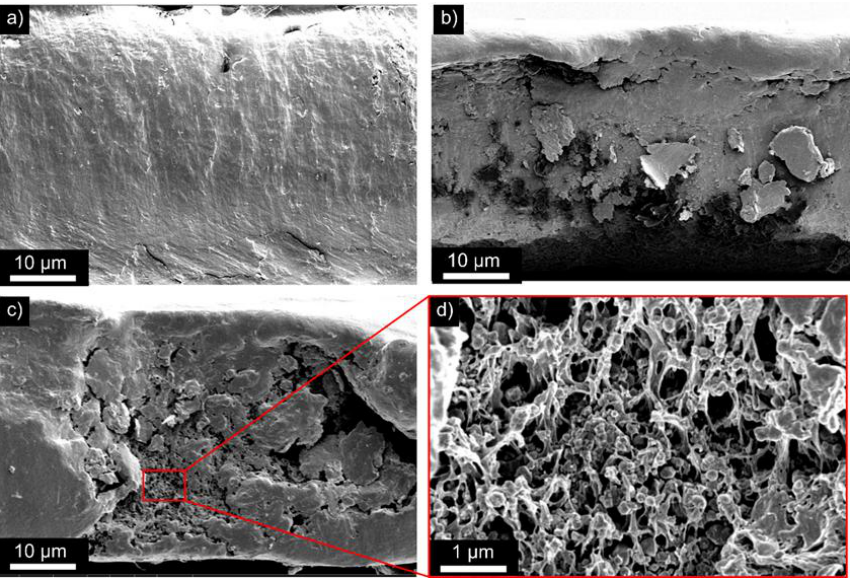
Figure 2. SEM micrographs of cross-sections of the P(VDF-TrFE) composite material with a (Cd:Zn)S particle concentration of ( a ) 1 vol %, ( b ) 10 vol %, and ( c , d ) 20 vol %.